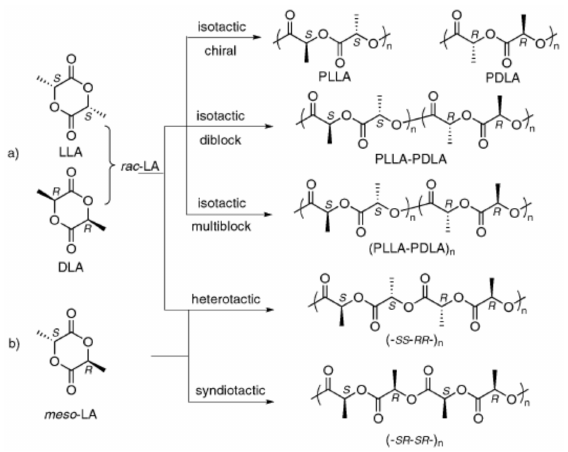
Figure 1. PLA microstructures. ( a ) Rac-Lactide, ( b ) meso-lactide. Reproduced with permission from Ref. [33]. Copyright 2010, The Royal Society of